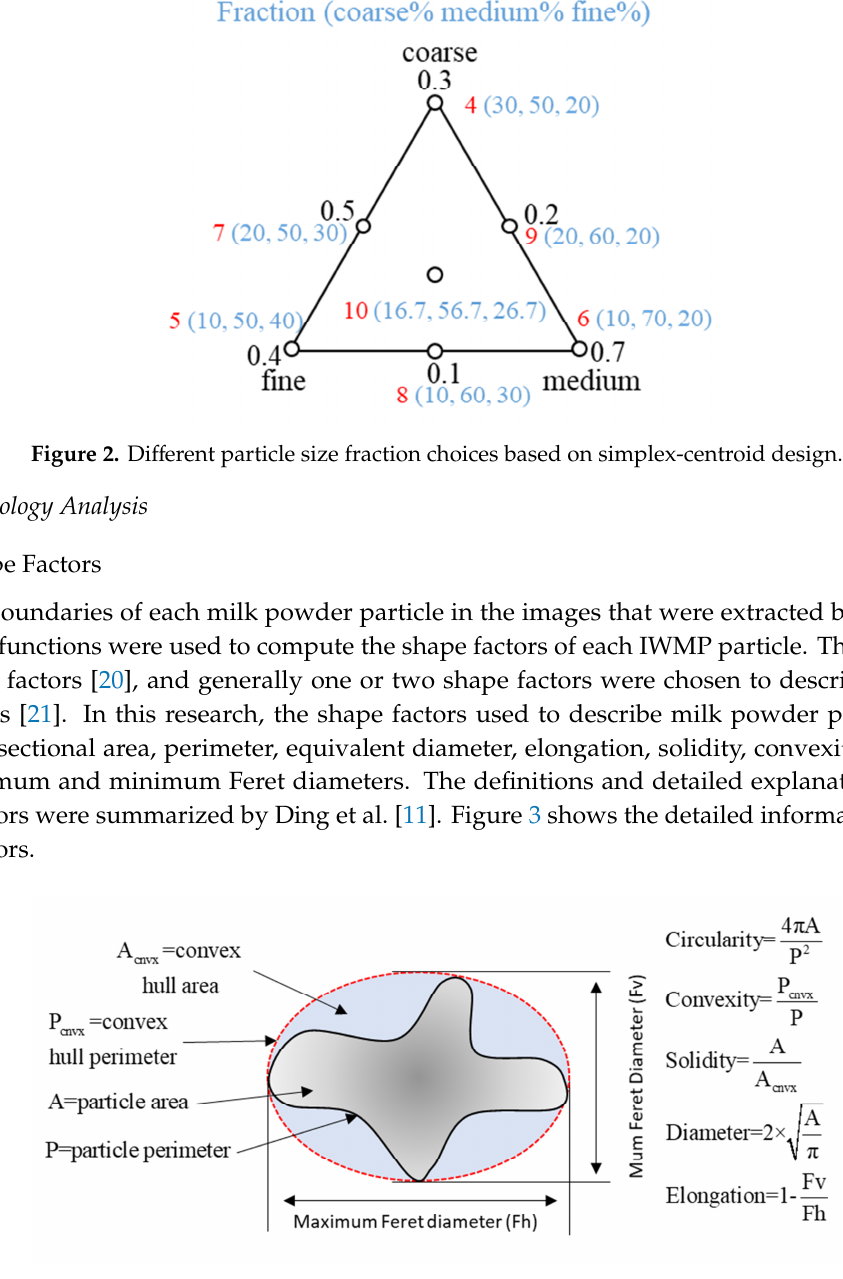
Figure 3. Shape factors that are used for model construction.